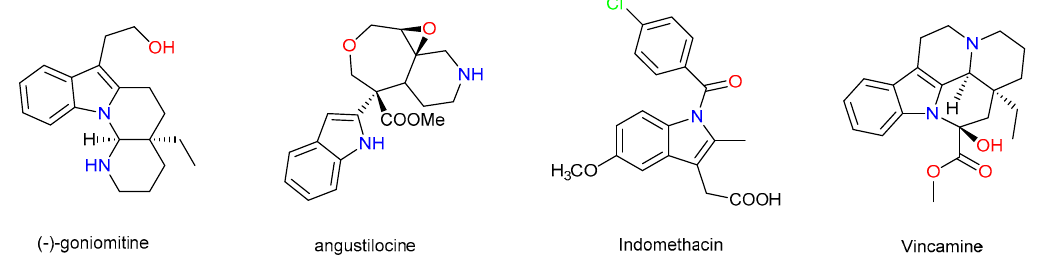
Figure 1. Representative molecules based on indole skeleton.